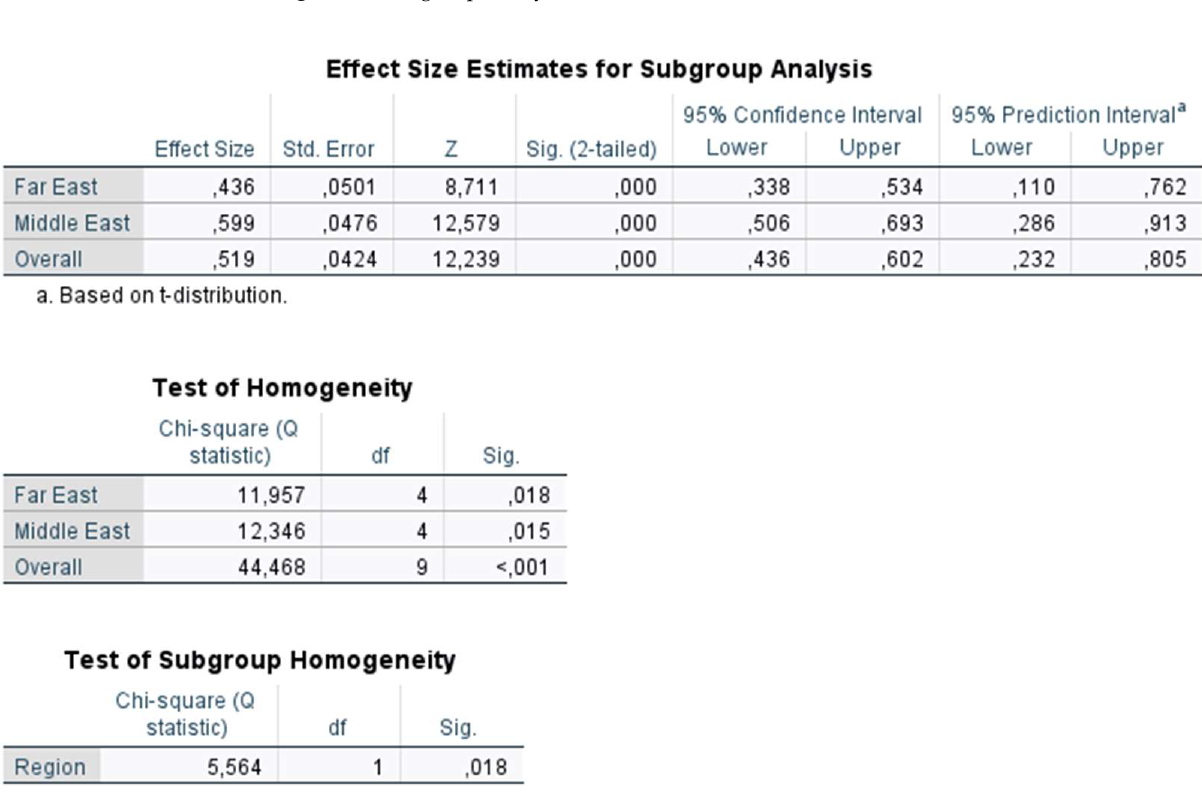
Figure 17. Subgroup Analysis Screen.